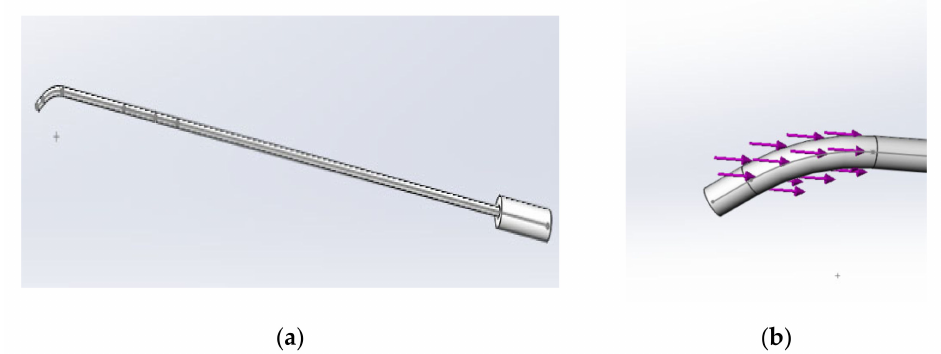
Figure 6. ( a ) The model of the catheter; ( b ) the stress direction of the catheter.